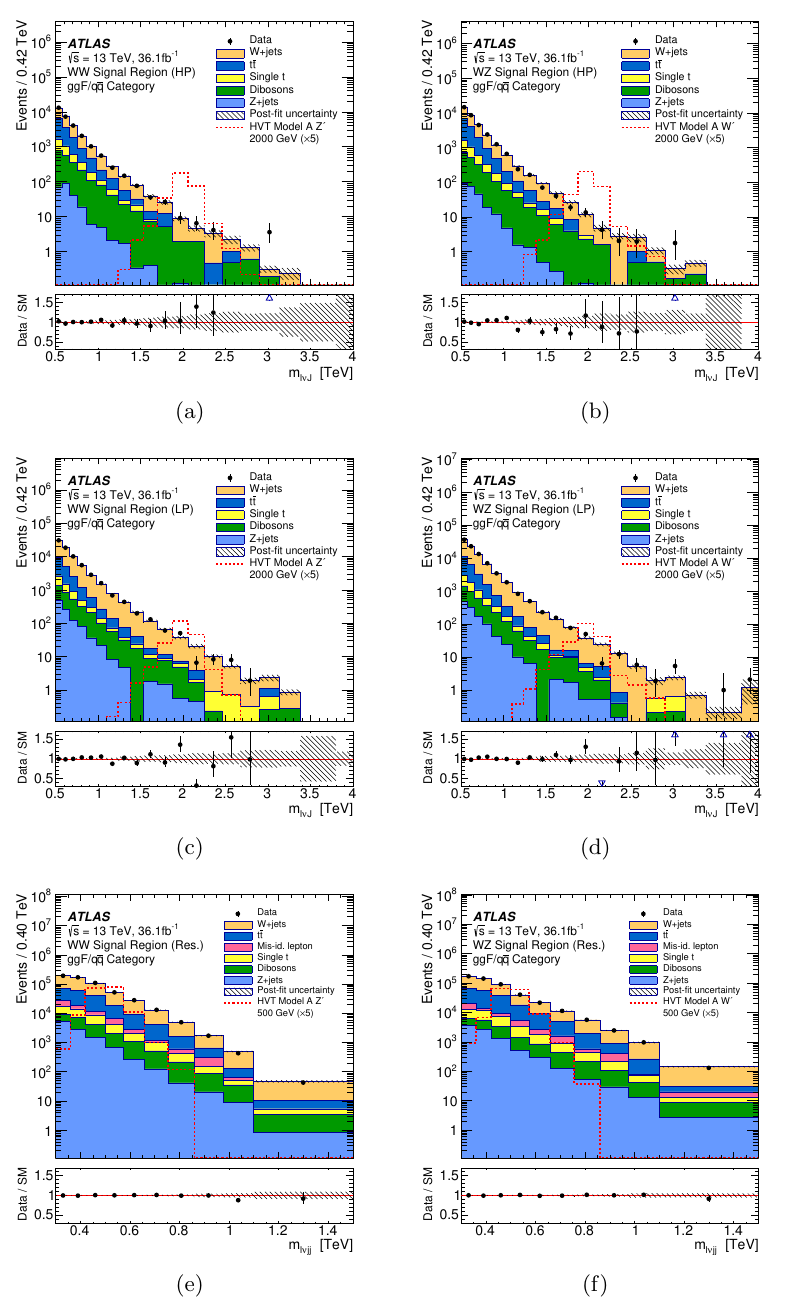
Figure 5 . Post-(cid:12)t signal region m ( WV ) distributions in the ggF = q(cid:22)q category. The merged high- purity (HP) sample of (a) WW and (b) WZ events, the merged low-purity (LP) sample of (c) WW and (d) WZ events and the resolved (Res.) sample of (e) WW and (f) WZ events are presented. The expected background is shown after the pro(cid:12)le likelihood (cid:12)t to the data, and signal predictions are overlaid. The HVT Model A signal at 2000 GeV is presented for the merged analysis, while the 500 GeV signal is shown in the resolved topology. The band denotes the statistical and systematic uncertainty in the background after the (cid:12)t to the data. The lower panels show the ratio of the ob- served data to the estimated SM background. The distribution of events is shown per mass interval corresponding to the penultimate bin width, while the over(cid:13)ow events are included in the last bin.